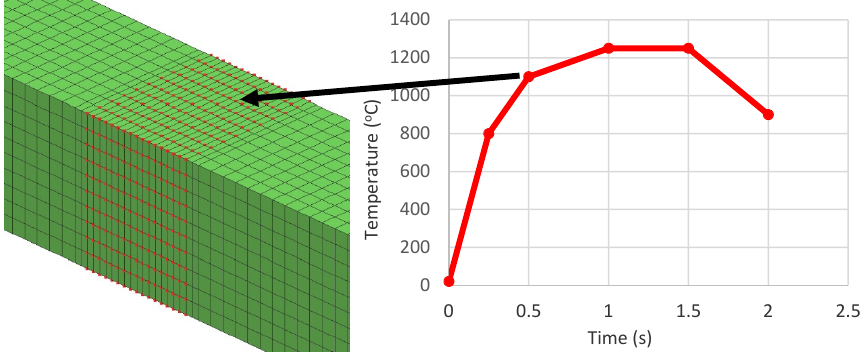
Figure 4. A scheme of load the mesh nodes with the defined thermal cycle when using the “Imposed Thermal Cycle” calculation technique.